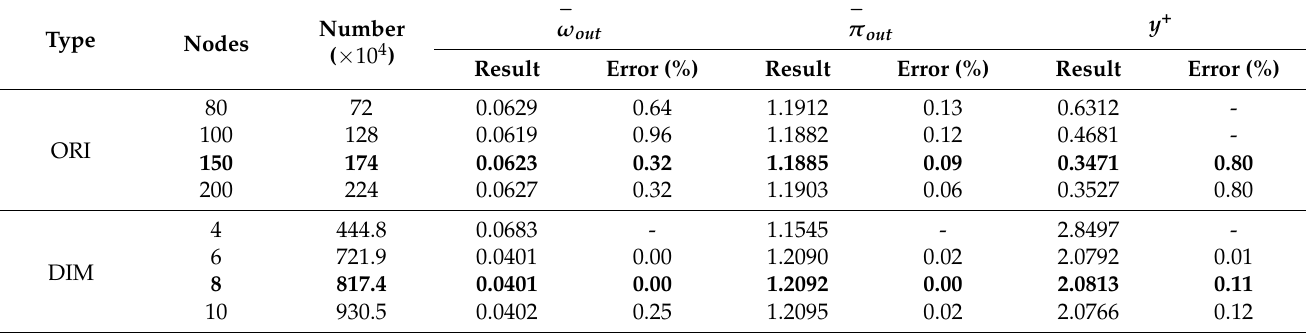
Table 3. Grid independency